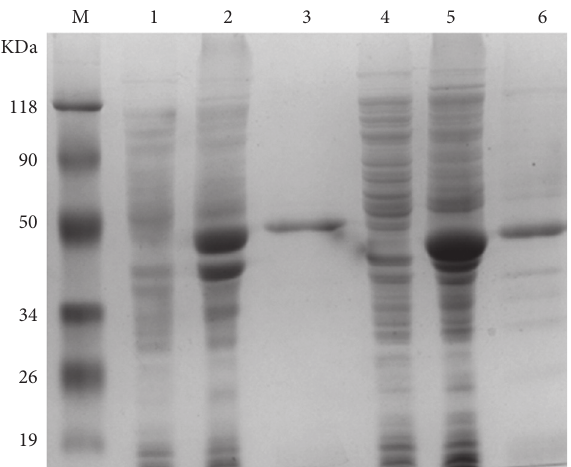
Figure 3: Analysis of recombinant fusion proteins through SDS-PAGE. SDS-PAGE gel of recombinant proteins: lane M-low MW protein markers; lane 1-crude supernatant of E. coli cells without IPTG induction; lane 2-crude EXY 4 supernatant of E. coli cells with IPTG induction; lane 3-purified EXY 4 proteins; lane 4-crude supernatant of E. coli cells without IPTG induction; lane 5-crude EXY4 supernatant of E. coli cells with IPTG induction; and lane 6-purified EXY 3 proteins.